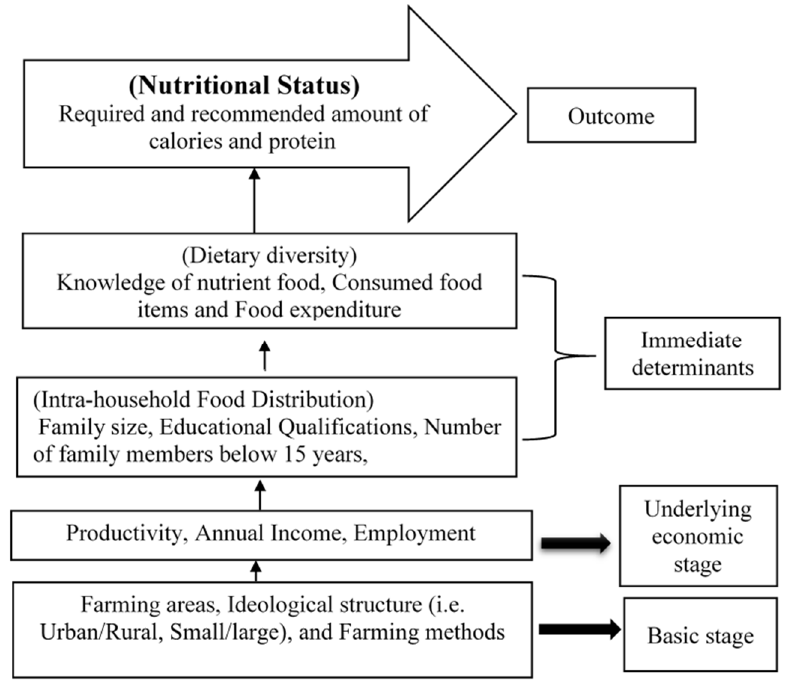
Figure 1. Conceptual framework for nutritional status (sources: Adopted from Chung 2012).